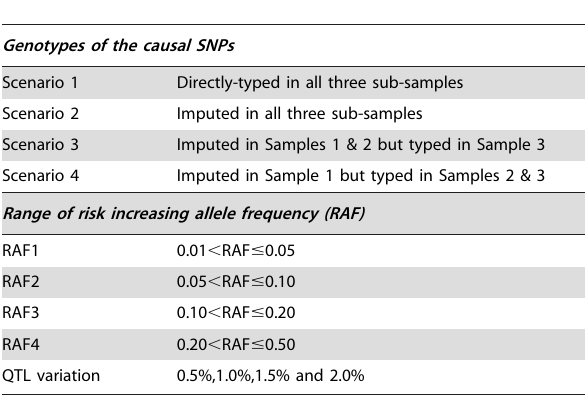
Table 2. Simulation schemes and